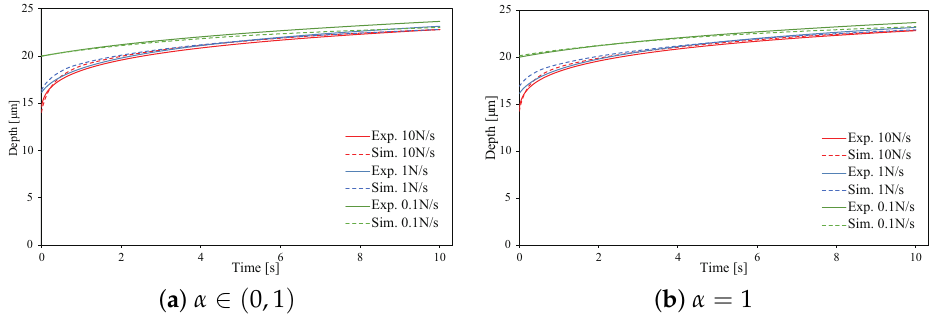
Figure 4. Load–depth curves obtained in the experiments and simulations using the determined material constants. The dashed lines indicate the simulation results.